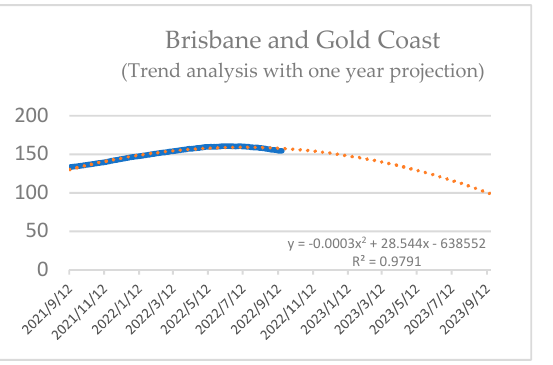
Figure 8. Trend analysis and one year prediction on housing prices for Brisbane and Gold Coast.